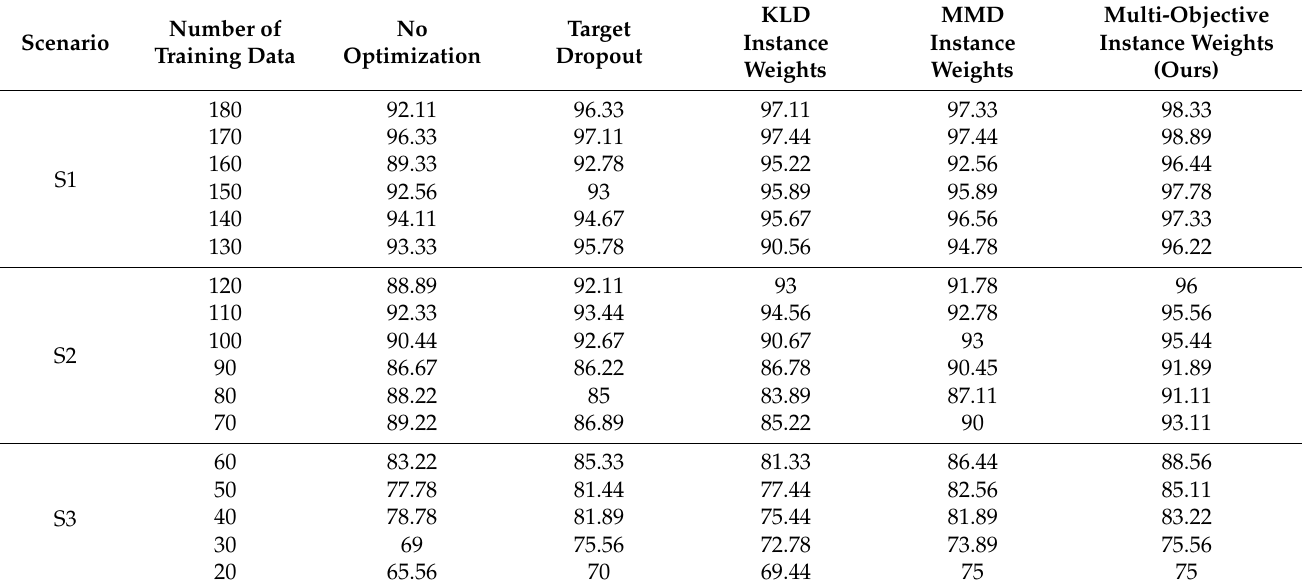
Table 5. Accuracy comparison results of different domain optimization methods.